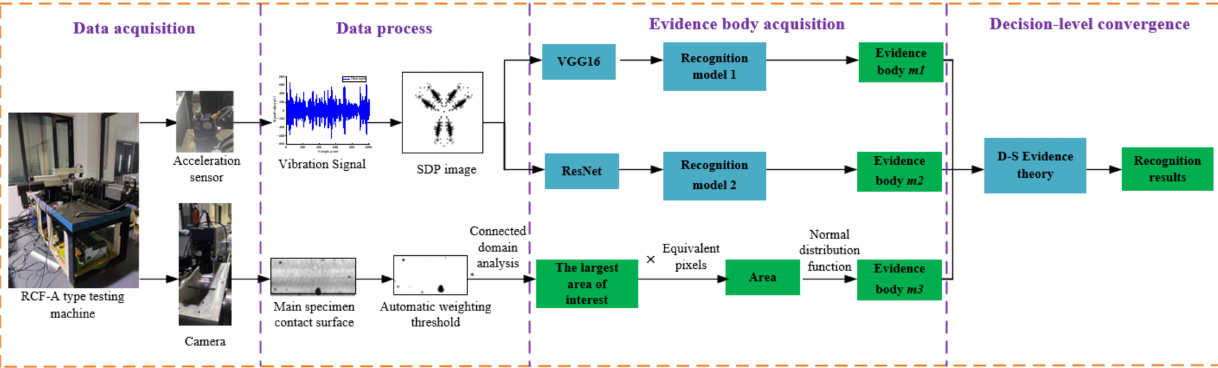
Figure 9. The process of contact fatigue state identification of the